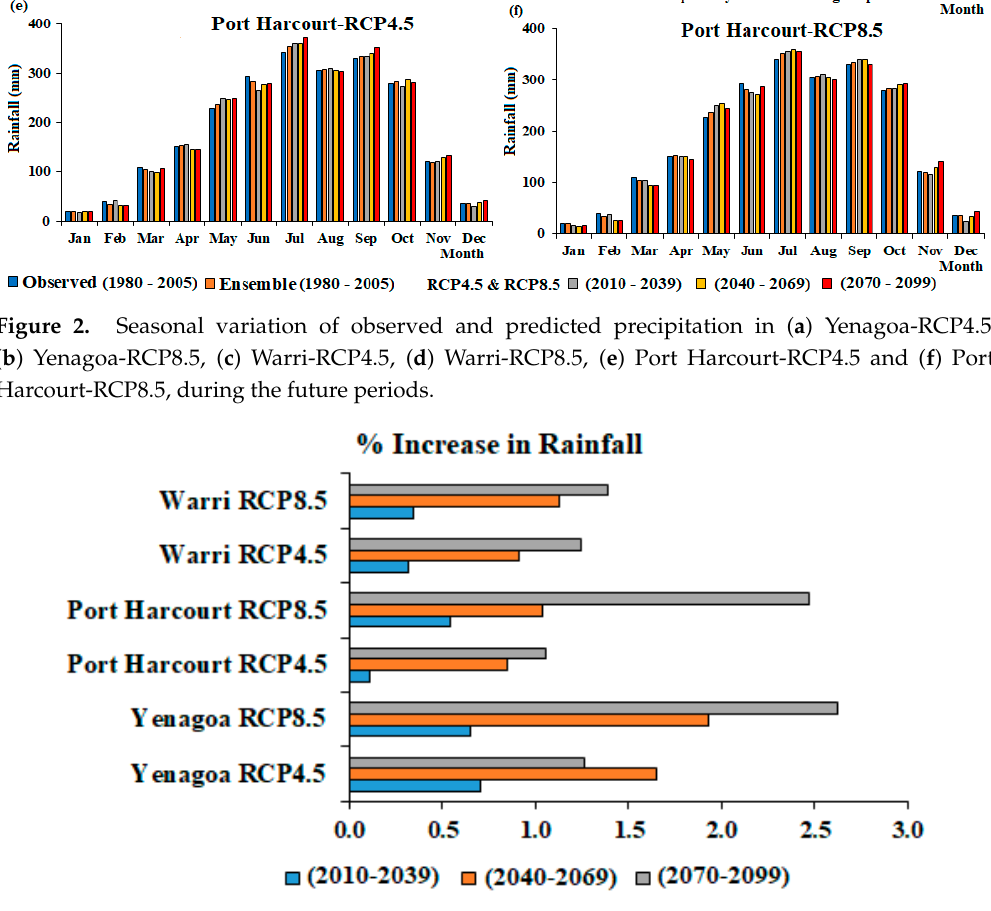
Figure 3. Percentage increase in predicted future rainfall in comparison with the observed rainfall across the study locations under the RCP4.5 and RCP8.5 emission scenarios.